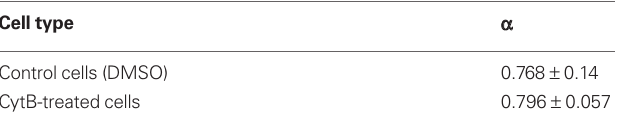
FiguRe 2 | Representative photographs of the cells; negative control with 1/100 volume of DMSO (A); and treated with 2 μM final concentration CytB (B). Actin filaments of these cells were stained with Alexa488 conjugated phalloidin. The negative control cells have not changed their shape compared with non-treated cells. Cells treated with CytB showed aggregation of actin molecules while adherence to the bottom of the culture chamber was maintained. The scale bars represent 10 μm. Table 2 | Anomaly parameters of control cells and CytB-treated cells.